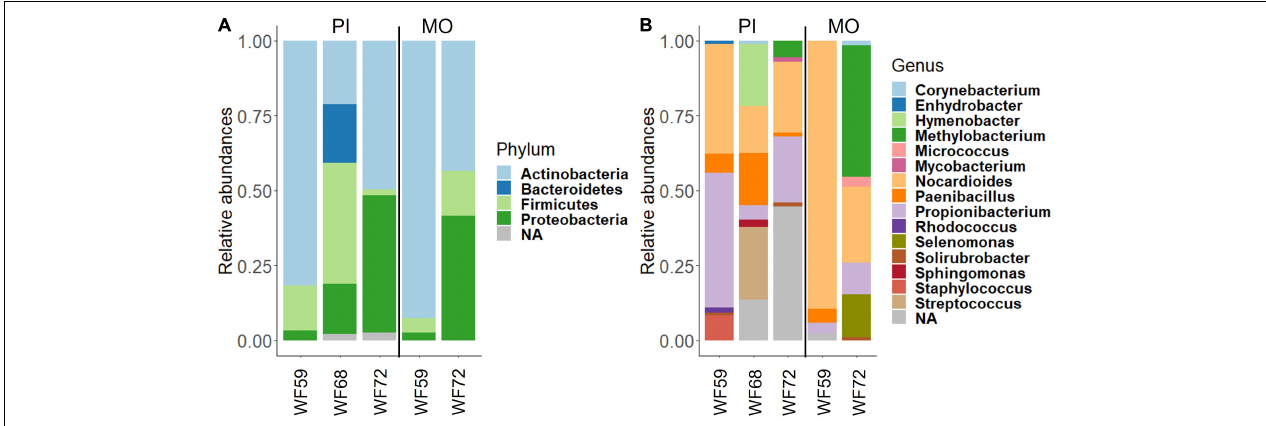
FIGURE 2 | Relative abundance of bacteria found in the buccal cavity mucus and posterior intestine of wild Nile tilapia. (A) Phylum level. (B) Genus level. Three samples from the posterior intestine of three wild fish (WF59, WF68, and WF72). However, for the buccal cavity we employed the samples from only two wild fish (WF59 and WF72). MO, buccal cavity; PI, posterior intestine; NA, Unclassified.